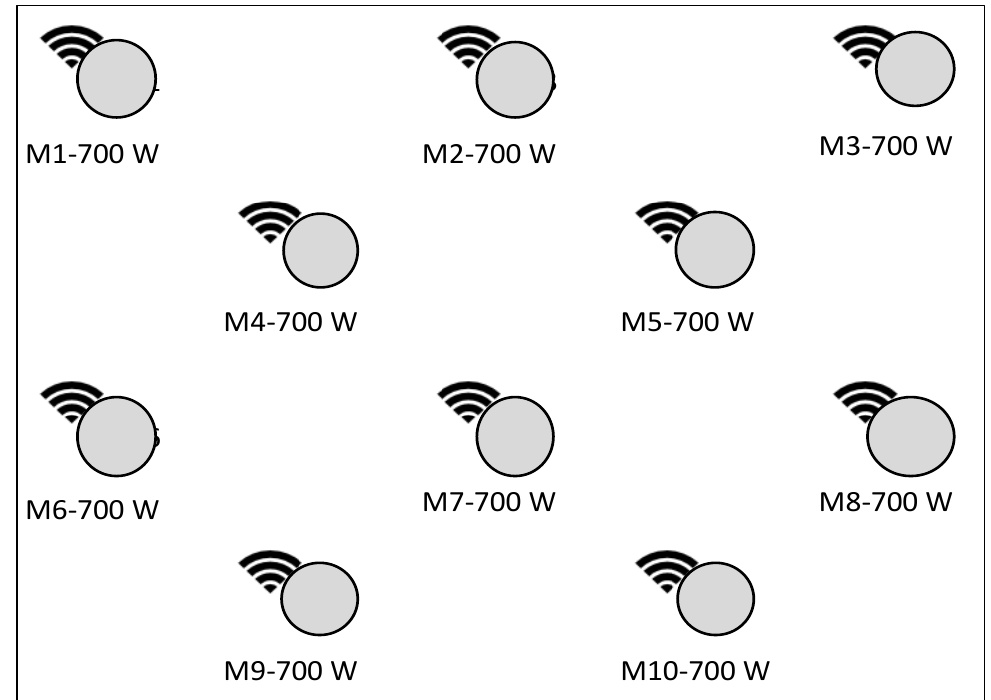
Figure 2: The layout of 10 pcs of 700-watt magnetrons. Source: Authors,